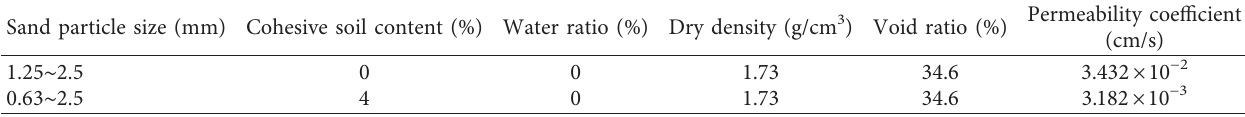
Table 2: Basic physical parameters of sand